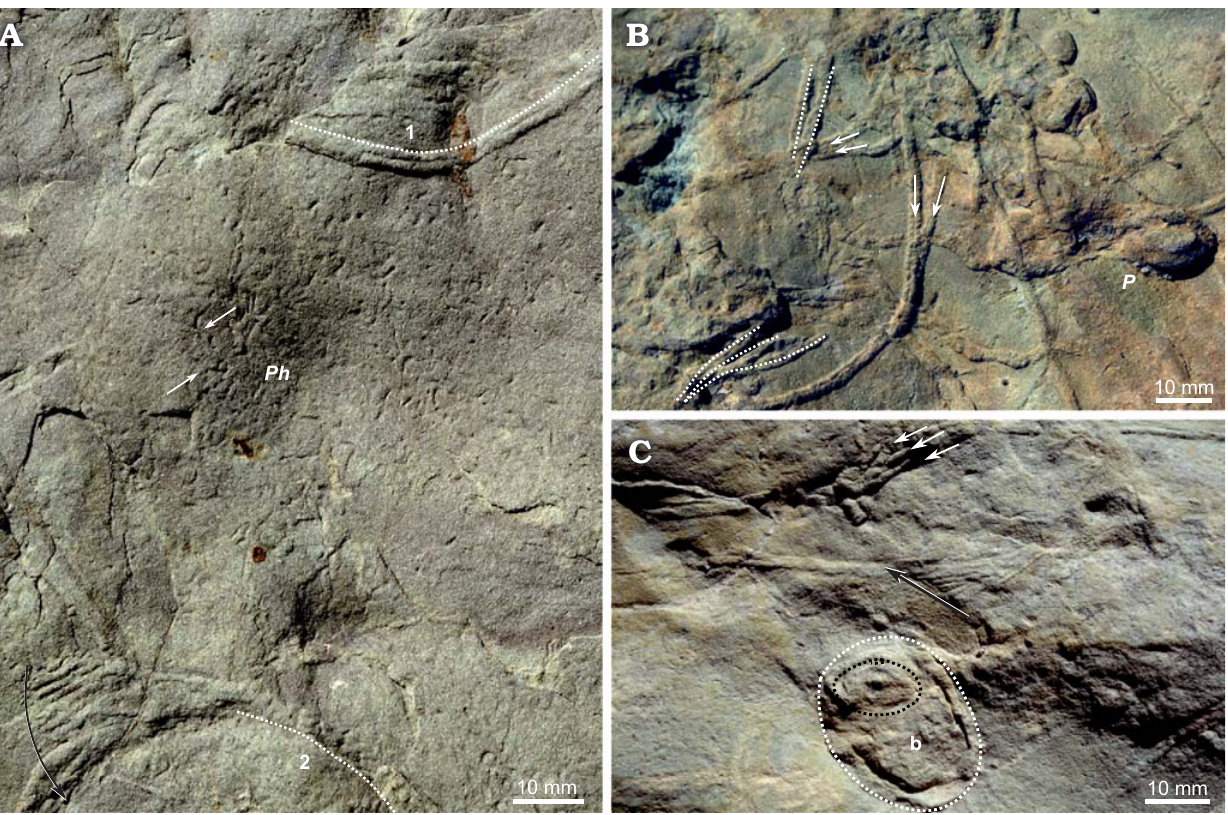
Fig. 6. Trace fossils co-occurring with “burrowing highways” of Gyrochorte ichsp. A . Mutual cross-cutting of Gyrochorte ichsp. (1, 2) and Phycosiphon incertum Fischer-Ooster, 1856 ( Ph ) exhibiting typical elbow-shaped turns (white arrows); Gyrochorte comosa Heer, 1865 overprinting Phycosiphon ichsp. (1, white doted line; bilobate crest of Gyrochorte well visible); Phycosiphon ichsp. overprinted by G. comosa (2, white doted line; bilobate crest of Gyrochorte ichsp. not clearly developed while bioturbated); G. comosa showing transition to Gyrochorte variabilis Fürsich, Alberti, and Pandey, 2017 expressed by fan-like appearance (shift of causative tube marked by black arrow). B . Gyrochorte comosa associated with Ptychoplasma ichsp. ( P ); sequorichnial behaviour of several Gyrochorte ichsp. producers is evidenced by parallel and/or overlapping traces (parallel traces, white doted lines; diverging/converging traces, white arrows). C . Parallel Gyrochorte comosa showing sequorichial behaviour (white arrows) associated with bivalve trace Siphonichnus ichsp. (b) (surrounded by black doted line) and cross-section of Lockeia ichsp. (surrounded by white doted line); G. comosa showing tran- sition to G. variabilis expressed by fan-like appearance (shift of causative tube marked by black arrow). All specimens left in the